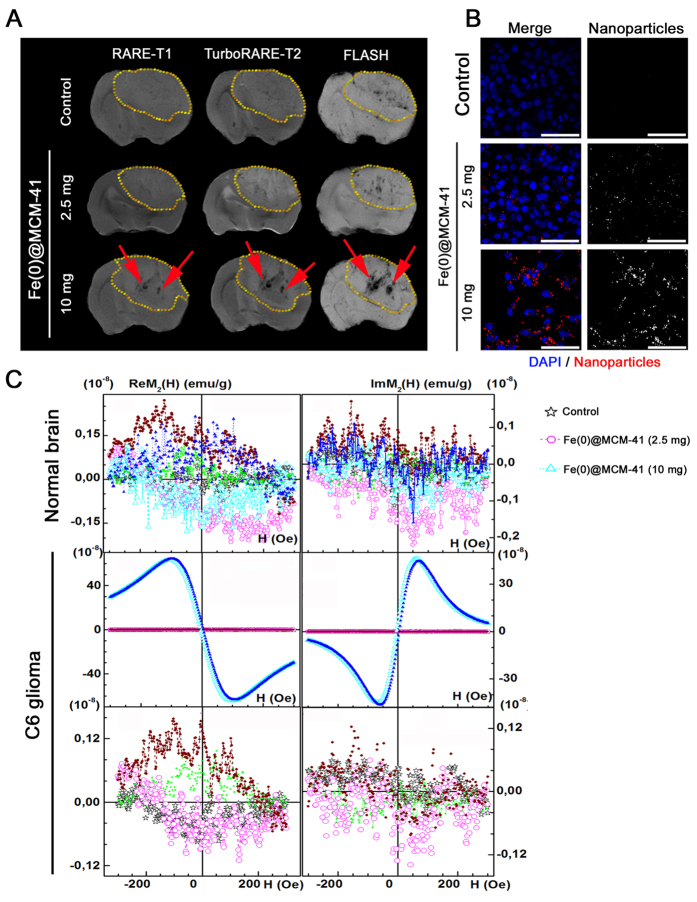
Accumulation of the Fe(0) @ MCM-41 nanoparticles in the glioma.(A) Magnetic resonance images for the control, animals treated with Fe(0) @ MCM-41 at dosage of 2.5 and 10 mg/kg. Images were obtained in RARE-T1, TurboRARE-T2 and FLASH regimens. Retention of the nanoparticles in the tumor presented as hypotensive zones on T2-weighted and gradient echo images (red arrows). (B) Immunofluorescent images of the brain tumors for the control and animals treated with Fe(0) @ MCM-41. Nuclei stained with DAPI (blue). Nanoparticles detected using reflective laser scanning at 488 nm (red). Scale bar, 40 μm. (C) Biodistribution of Fe-MSNs nanoparticles in normal brain and tumor of the treated animals from NLR- M2 data. Solid symbols are used for curves recorded at direct H-scan and open symbols for the reverse one.